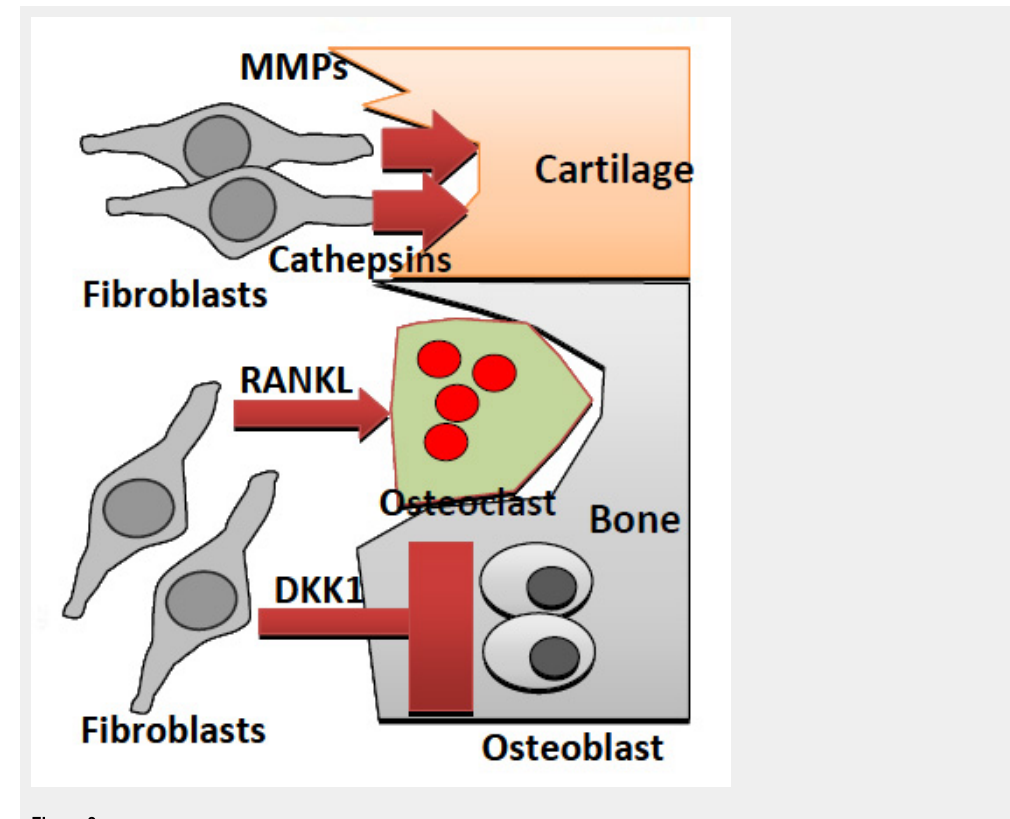
Figure 3 Fibroblast contribute to joint damage. Pannus tissue consists of activated RASFs that attach to and damage cartilage through production of MMPs and cathepsins. In addition, fibroblasts secrete RANKL, which promotes osteoclast differentiation and activation, leading to bone erosions. Furthermore production of DKK-1 inhibits Wnt signaling pathways that normally promote anabolic osteoblast activity, preventing repair of bone erosions. Abbreviations: MMPs: matrix metalloprotenaises; RANKL: receptor activator of nuclear factor k B ligand; DKK-1: dickkopf-1.